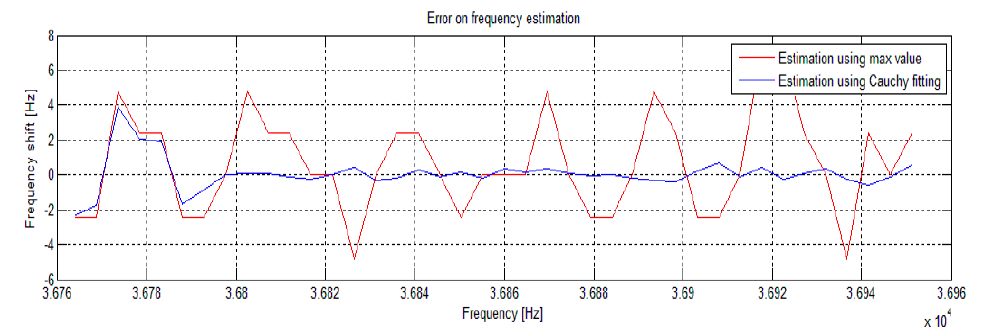
Figure 5. Error on resonance frequency estimation using “maximum value” method and using “Cauchy fitting” method as a function of resonance frequency.